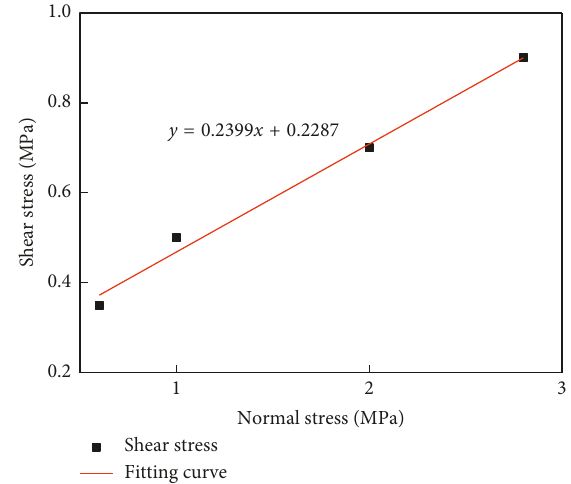
Figure 14: The relationship between the shear stress and the normal stress of the test point